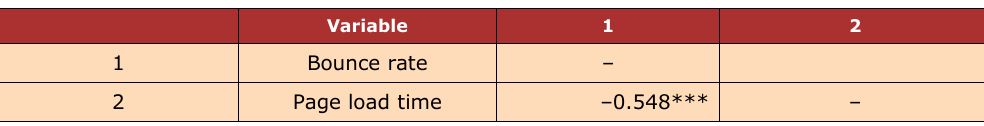
Table 3. Correlation analysis between forum’s bounce rate and page load time